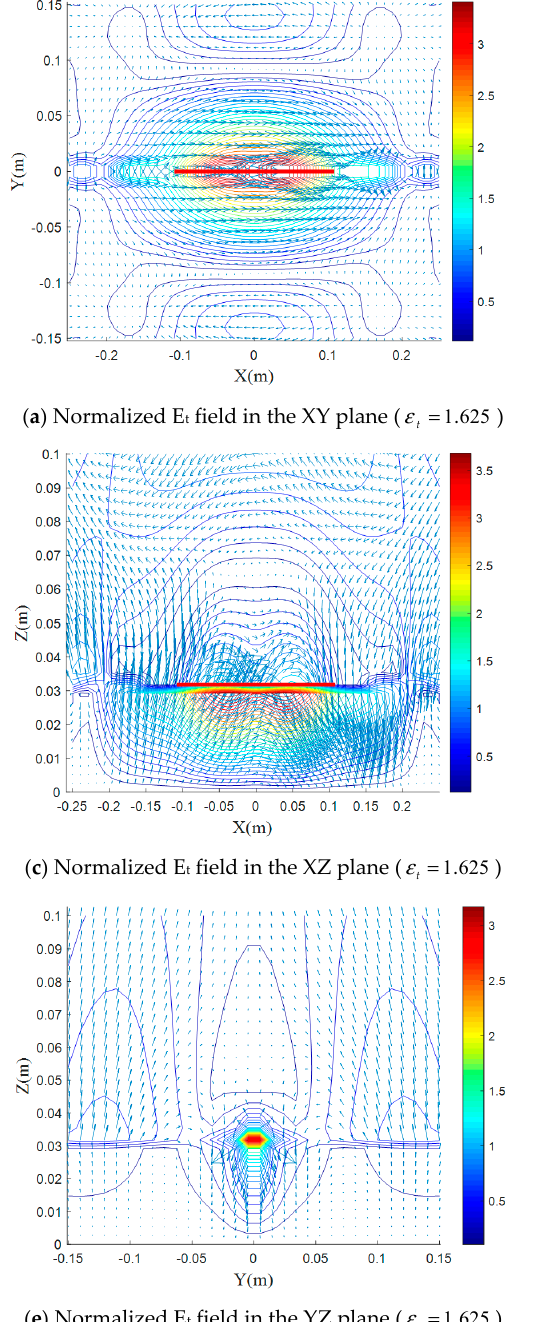
ε with 253 . = ε , 1 = μ and 1 = μ in the t z z t